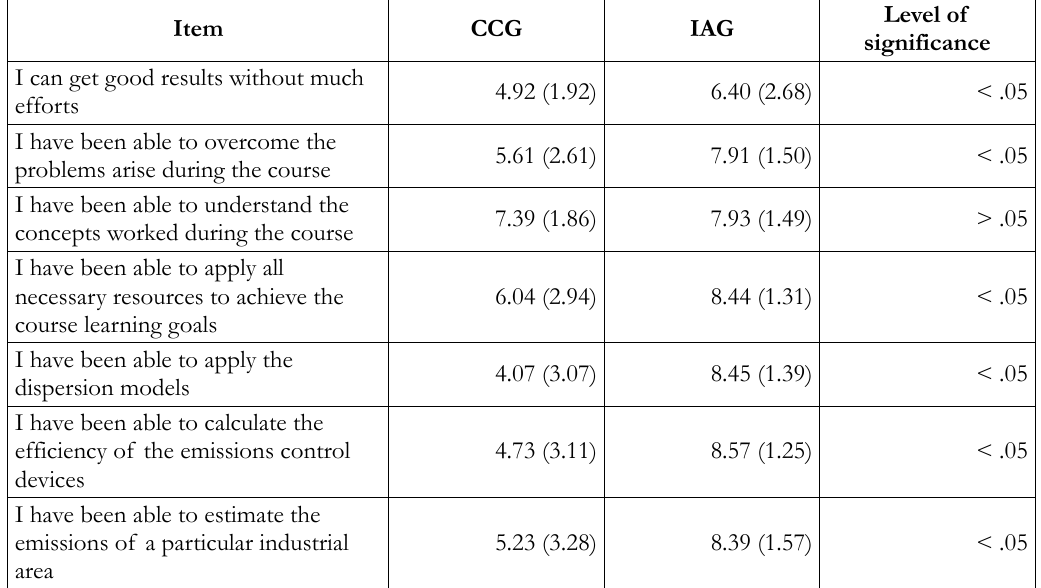
Table 3. Self-efficacy score comparison of the participants of control and intervention assessment